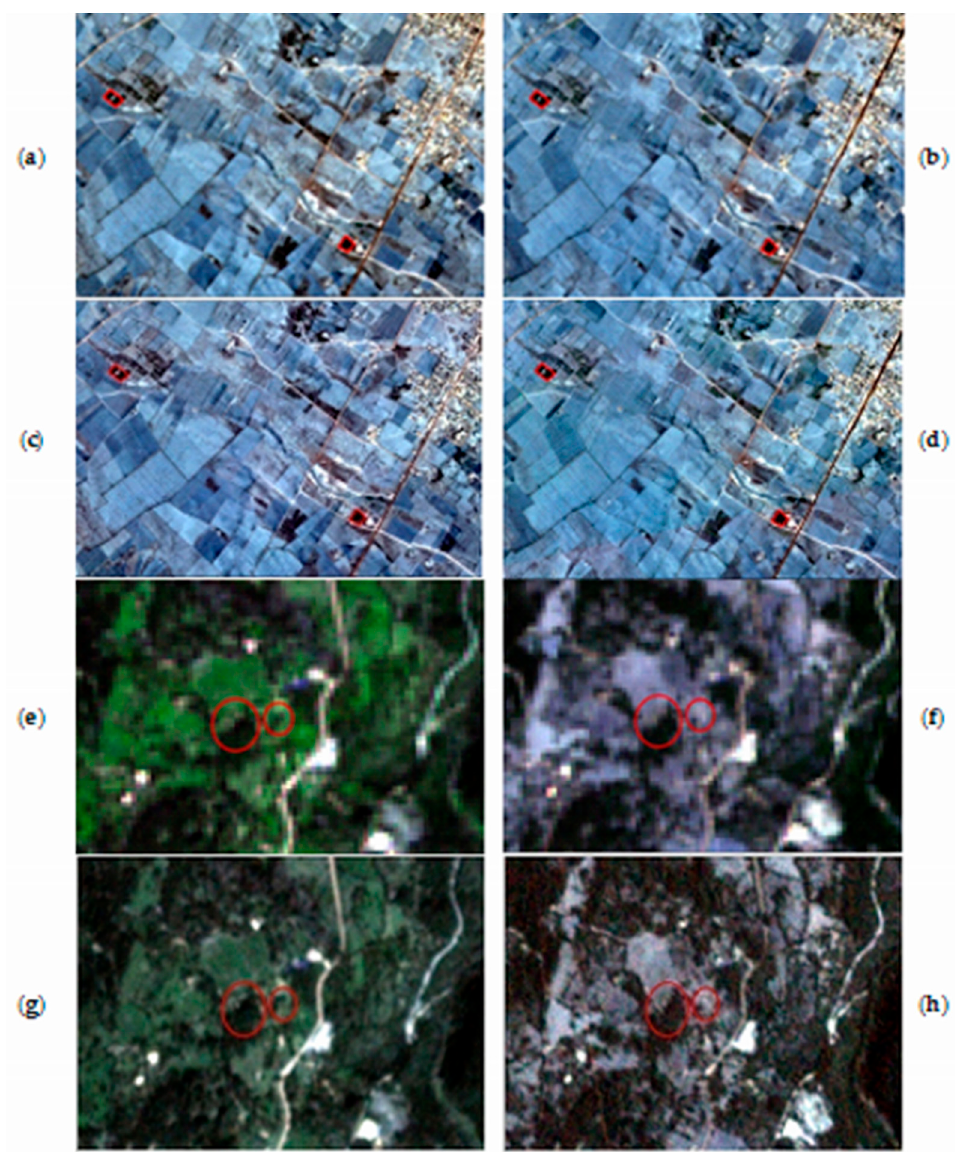
Figure 3. ( a ): Sentinel-2 RGB image (RGB-248) in 25/February/2020, Tunisian study areas, ( b ): Sentinel-2 RGB image (RGB-248) in 26/August/2020, Tunisian study areas, ( c ): PlanetScope RGB image (RGB-234) in 25/February/2020, Tunisian study areas, ( d ): PlanetScope RGB image (RGB-234) in 25/August/2020, Tunisian study areas, ( e ): Sentinel-2 RGB image (RGB-248) in 25/February/2020, Greek study area, ( f ): Sentinel-2 RGB image (RGB-248) in 18/August/2020, Greek study areas, ( g ): PlanetScope RGB image (RGB-234) in 25/February/2020, Greek study areas, ( h ): PlanetScope RGB image (RGB-234) in 18/August/2020, Greek study areas. The simple false-color composite fails to depict the OMW disposal areas efficiently for Greek study areas (indicated inside the red frame).